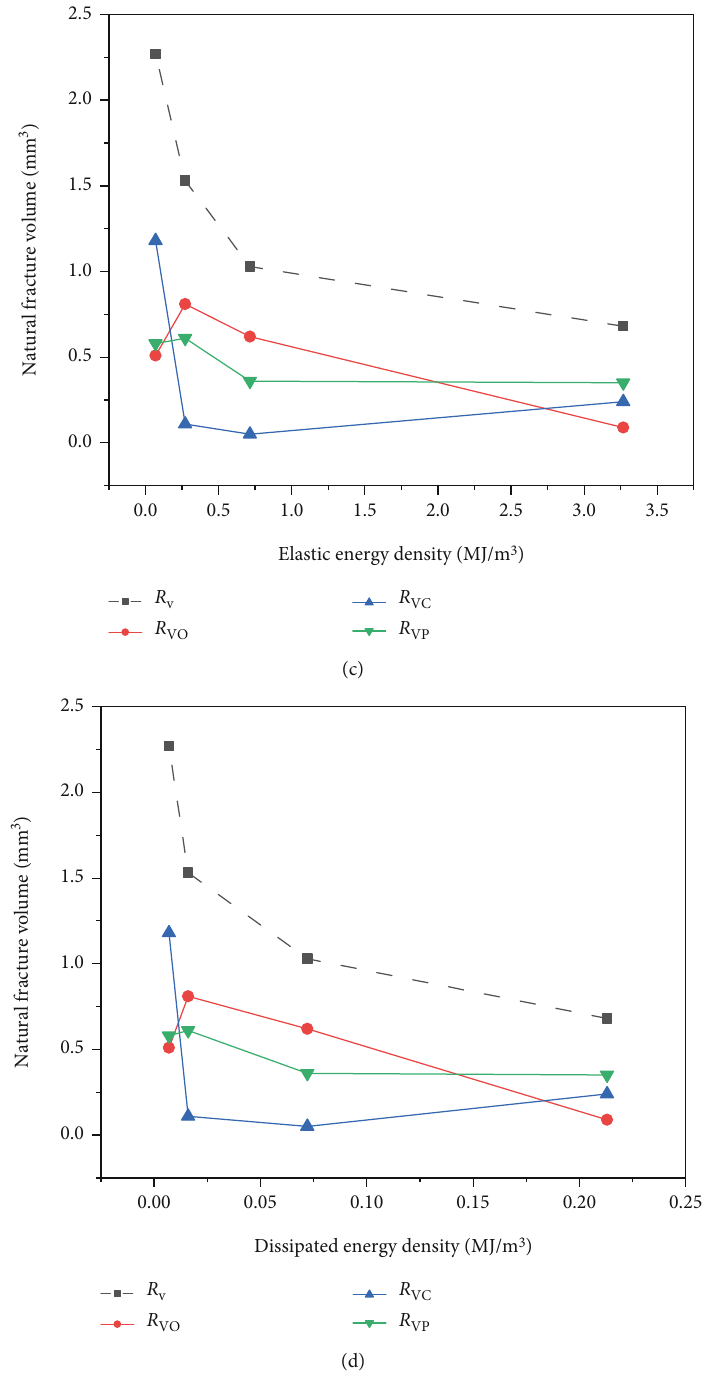
Figure 6: Evolution of elastic energy and dissipated energy for naturally fractured marble samples ((a, b) comparison of the elastic energy and dissipated energy with cycle number; (c, d) plots of natural fracture volume against the elastic and dissipated